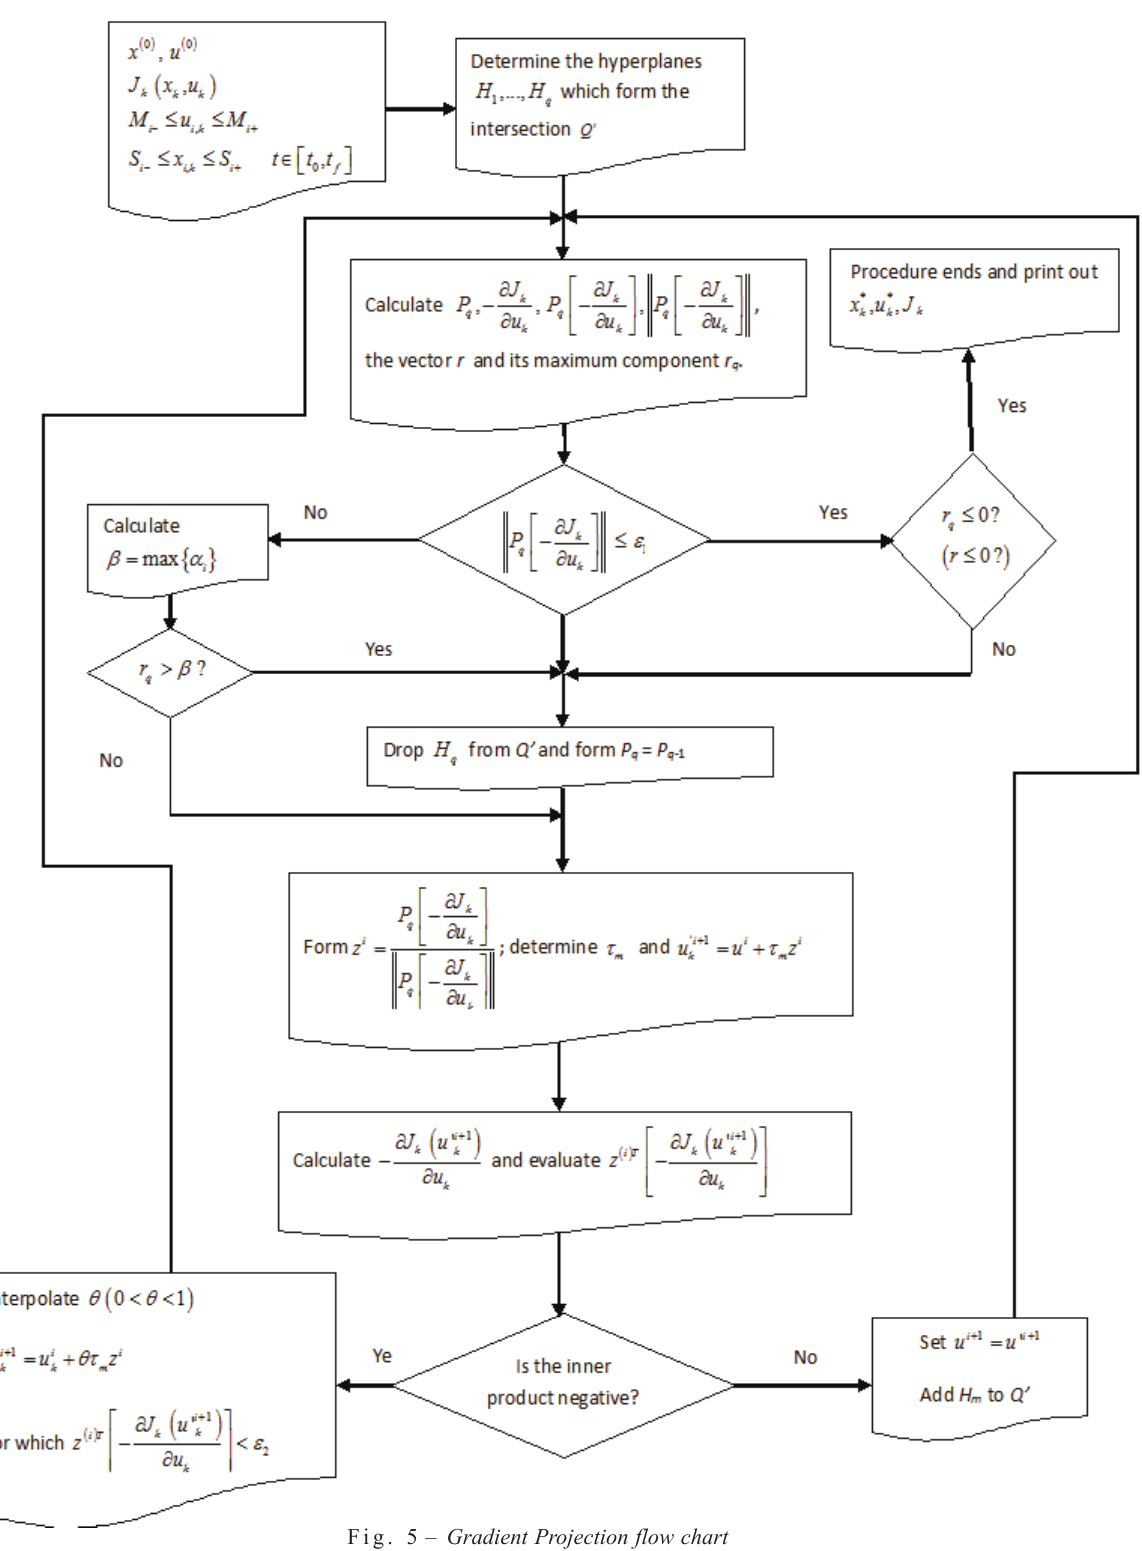
Fig. 5 – Gradient Projection flow Fig. 5 Gradient Projection flow chart